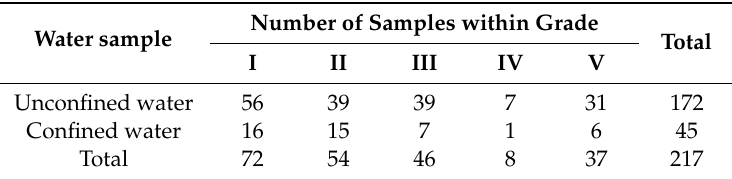
Table 4. Quality assessment by fuzzy comprehensive